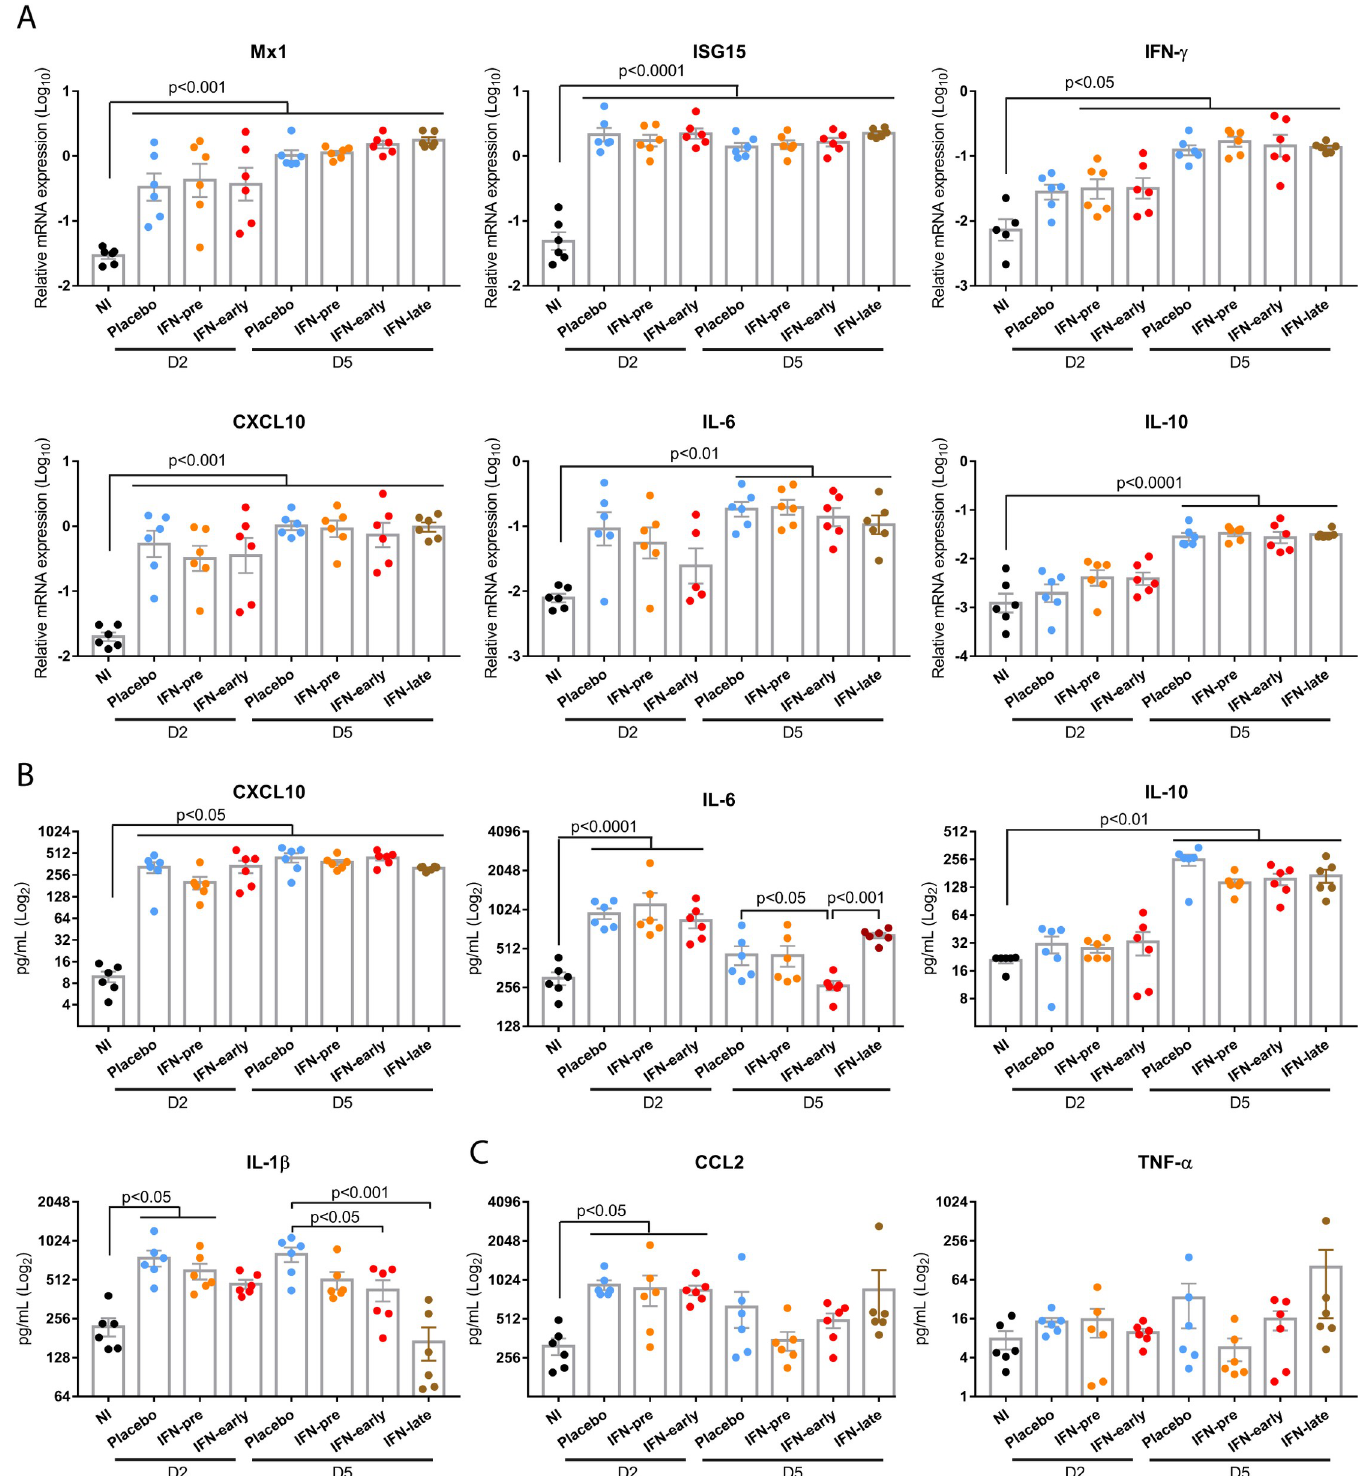
Fig 4. Impact of type I IFN- α treatment on the immune response to SARS-CoV-2. (A) Lung transcripts levels of Mx1, ISG15, IFN- γ , CXCL10, IL-6 and IL-10 relative to the housekeeping genes RPL18 and RPS6KB1 determined by RT-qPCR. (B) Lung protein levels for CXCL10, IL-6, IL-10 and IL-1 β protein levels determined by ELISA or a multiplex assay. (C) Plasmatic protein levels for CCL2 and TNF- α determined by a multiplex assay. D2: day 2 post infection; D5: day 5 post infection; D15: day 15 post infection. Results are expressed as means ± SEM. Statistical analysis: one-way ANOVA with Tukey’s multiple comparisons test.